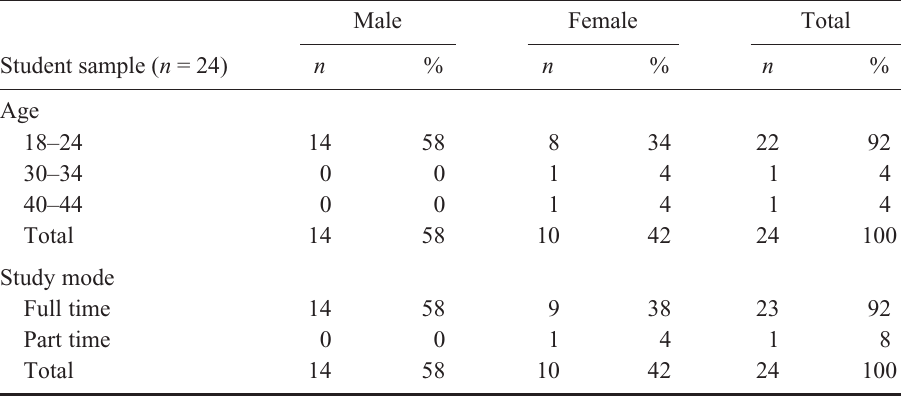
Table 1. Demographic details of study participants.